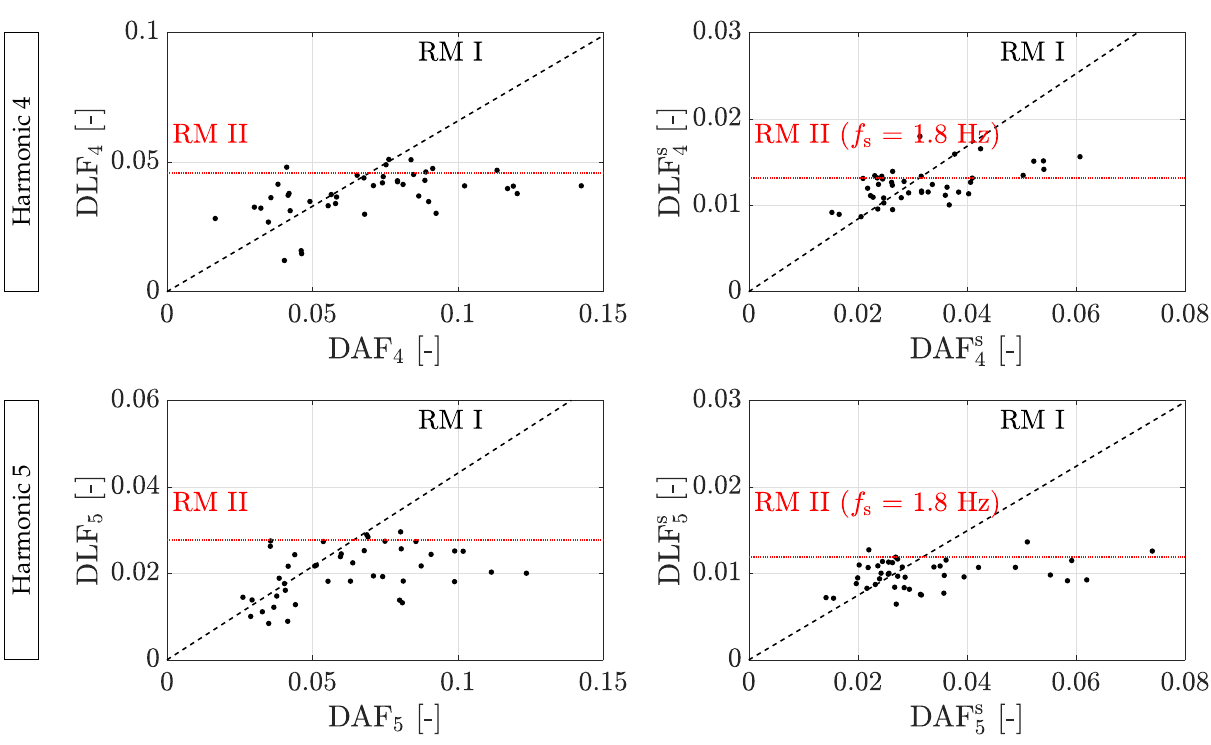
Figure 9. The experimentally observed relationship between the dynamic acceleration factor (DAF) and dynamic loading factor (DLF). Indication of the magnitude of the transfer function (slope of the dashed line) which is used in RM I and the DLF proposed by the load model of Živanovi´c et al. [26] and is used in RM II (red dotted